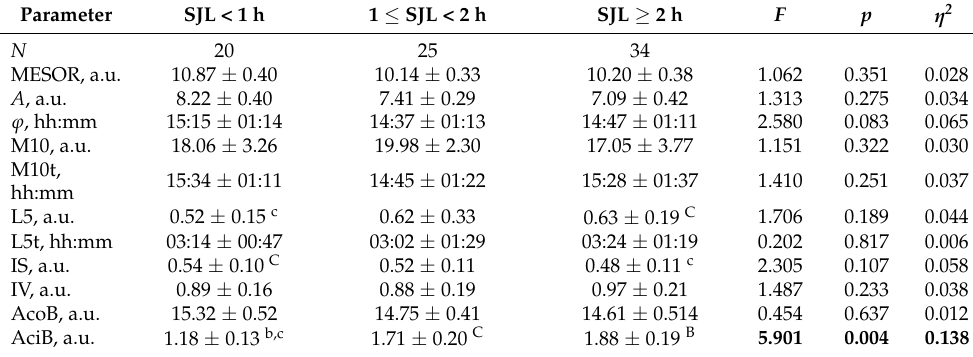
Abbreviations as in Table 1. For details see footnote to Table